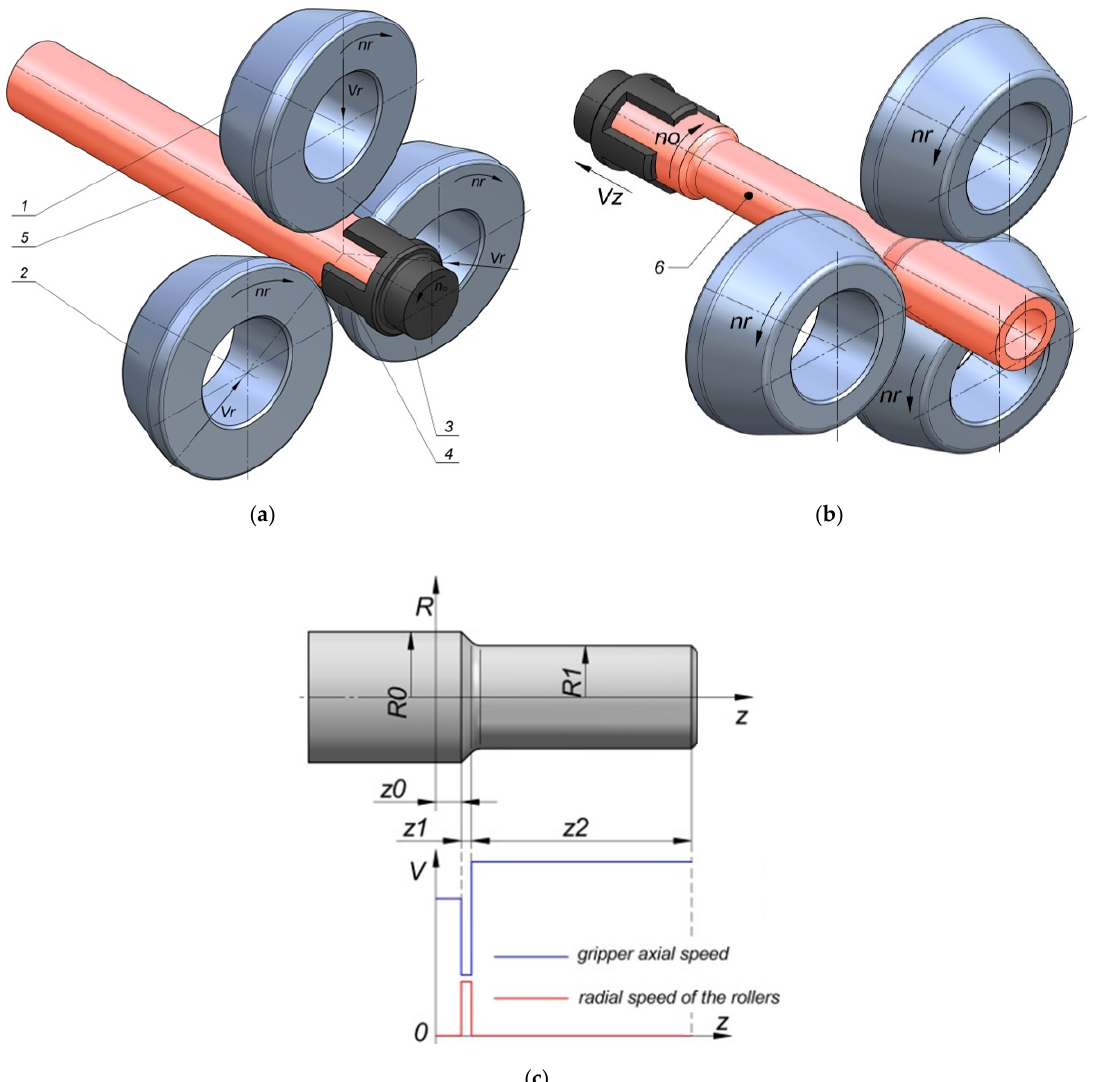
Figure 1. Scheme of the skew rolling process of stepped shafts in a three-roll skew rolling mill with the controlled movement of the tools and the billet: ( a ) the beginning of the process, ( b ) the advanced phase of the process, ( c ) changes in the radial velocity of the tools and the axial velocity of the billet based on the shape of the rolled product; 1, 2, 3—rolls, 4—gripper, 5—billet, 6—formed